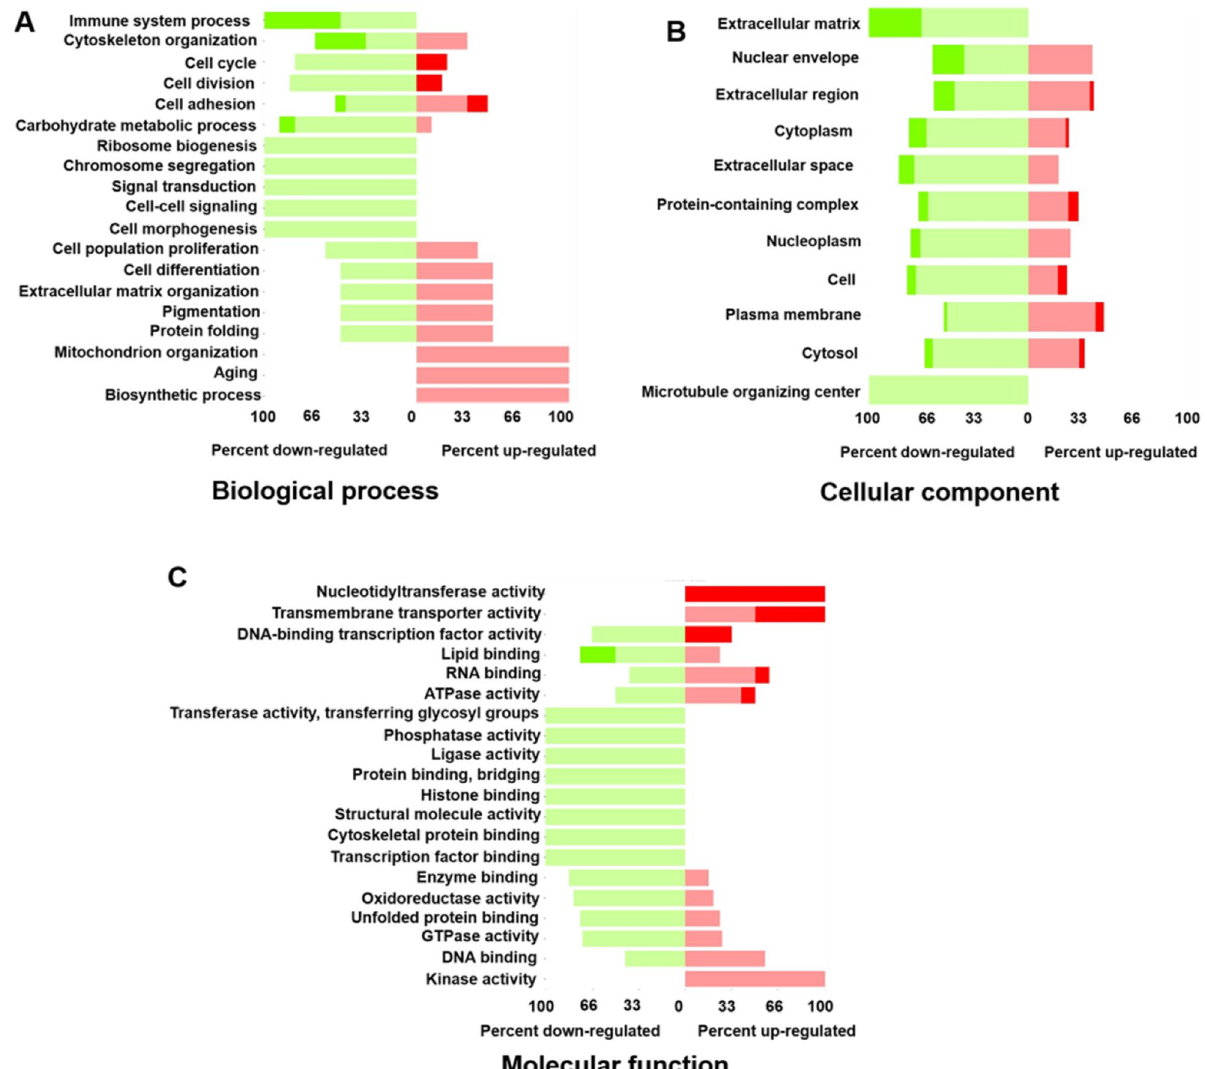
Figure 5. GO enrichment analysis of differentially expressed proteins in young and adult PV leaflets. GO molecular function ( A ), biological process ( B ), and cellular component ( C ) enrichment analyses of up-regulated and down-regulated proteins (Adult vs. Young, dark color represents proportions that passes FDR of 0.05, indicating statistical